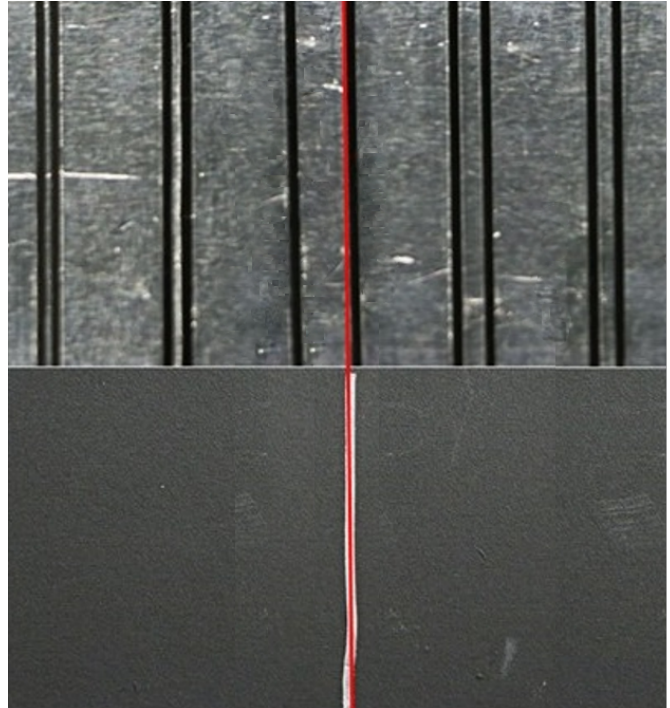
Figure 4. Sample front and rear view to understand origin of white marker line at position 41mm, Figure 3. The rear side of the sample has been observed by the IR camera and the front side has been excited by a laser array. The defects on the front side are shown by blackened stripes (5 pairs). The marker line on the rear side is in the same position as the left edge of the right stripe from the third pair. The distances between the pairs are (left to right): 0.5, 1, 3, 2, 1.3mm. A stripe is 1mm wide and the distance of each pair is around